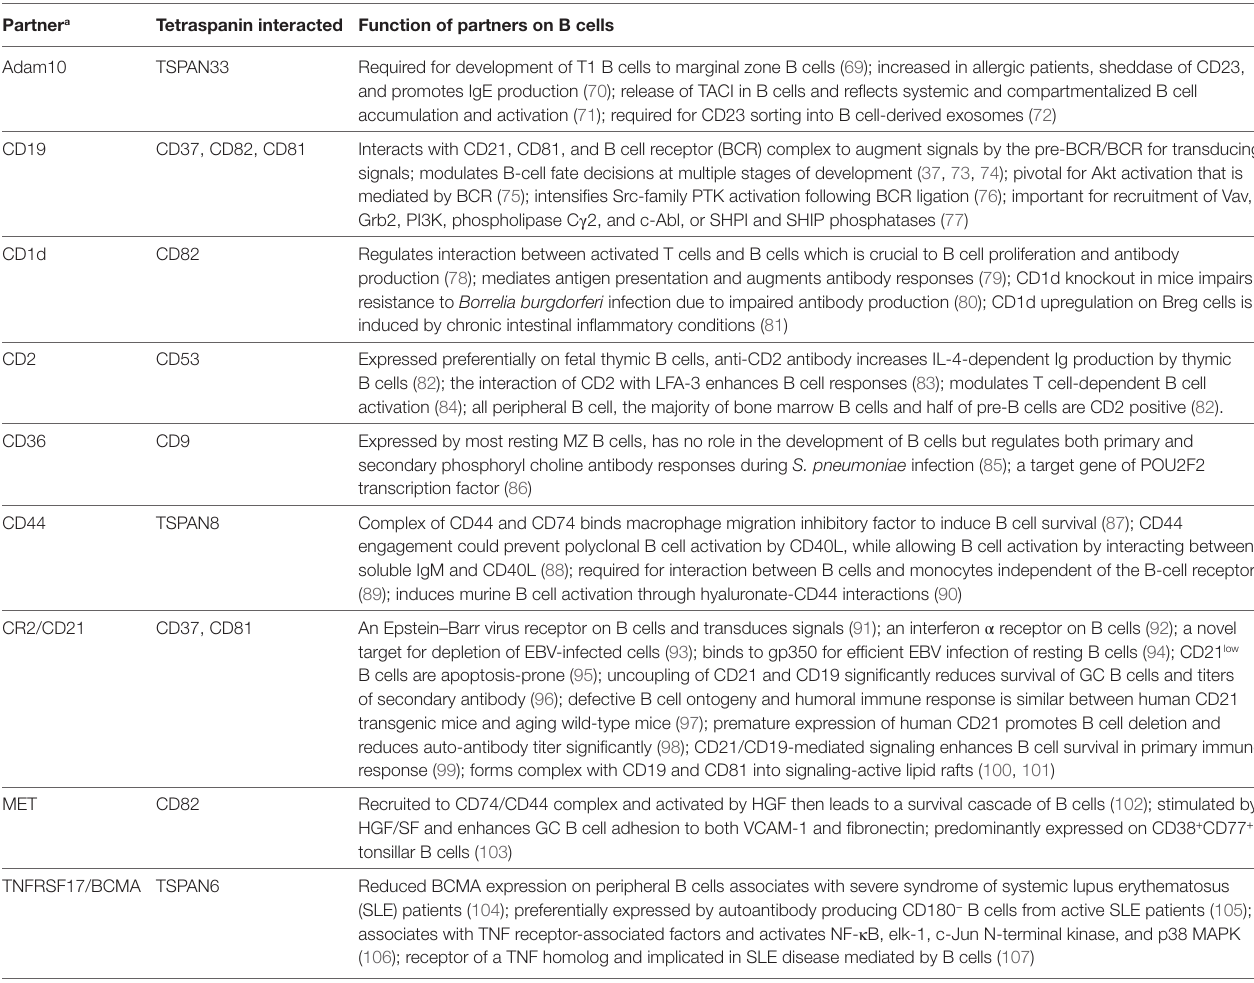
TABLe 4 | Functions of tetraspanin partners on B cells. Partner